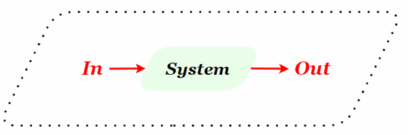
Figure 8. The Strategic Plane focuses on system-wide